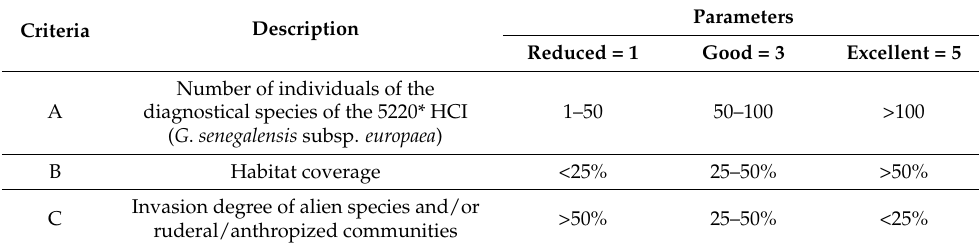
Table 1. List of criteria used in the assessment phase of the 5220* HCI for the study area. Description and parameters used for the proposed scale. HCI: Habitat of Community